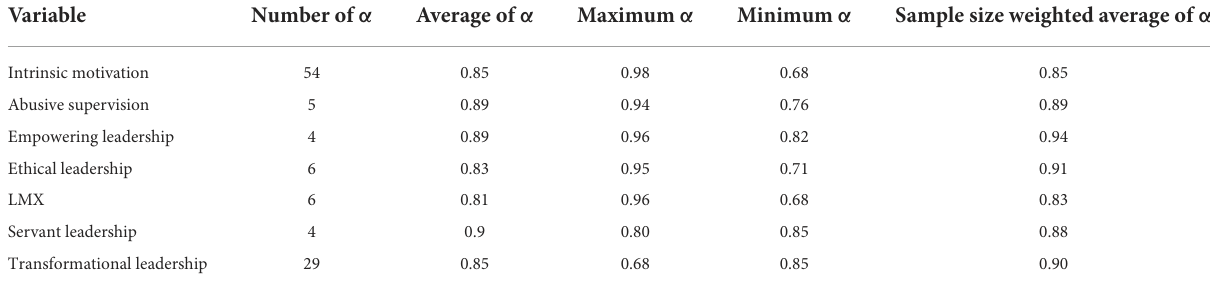
TABLE 2 Cronbach’s α reliabilities of the current study.